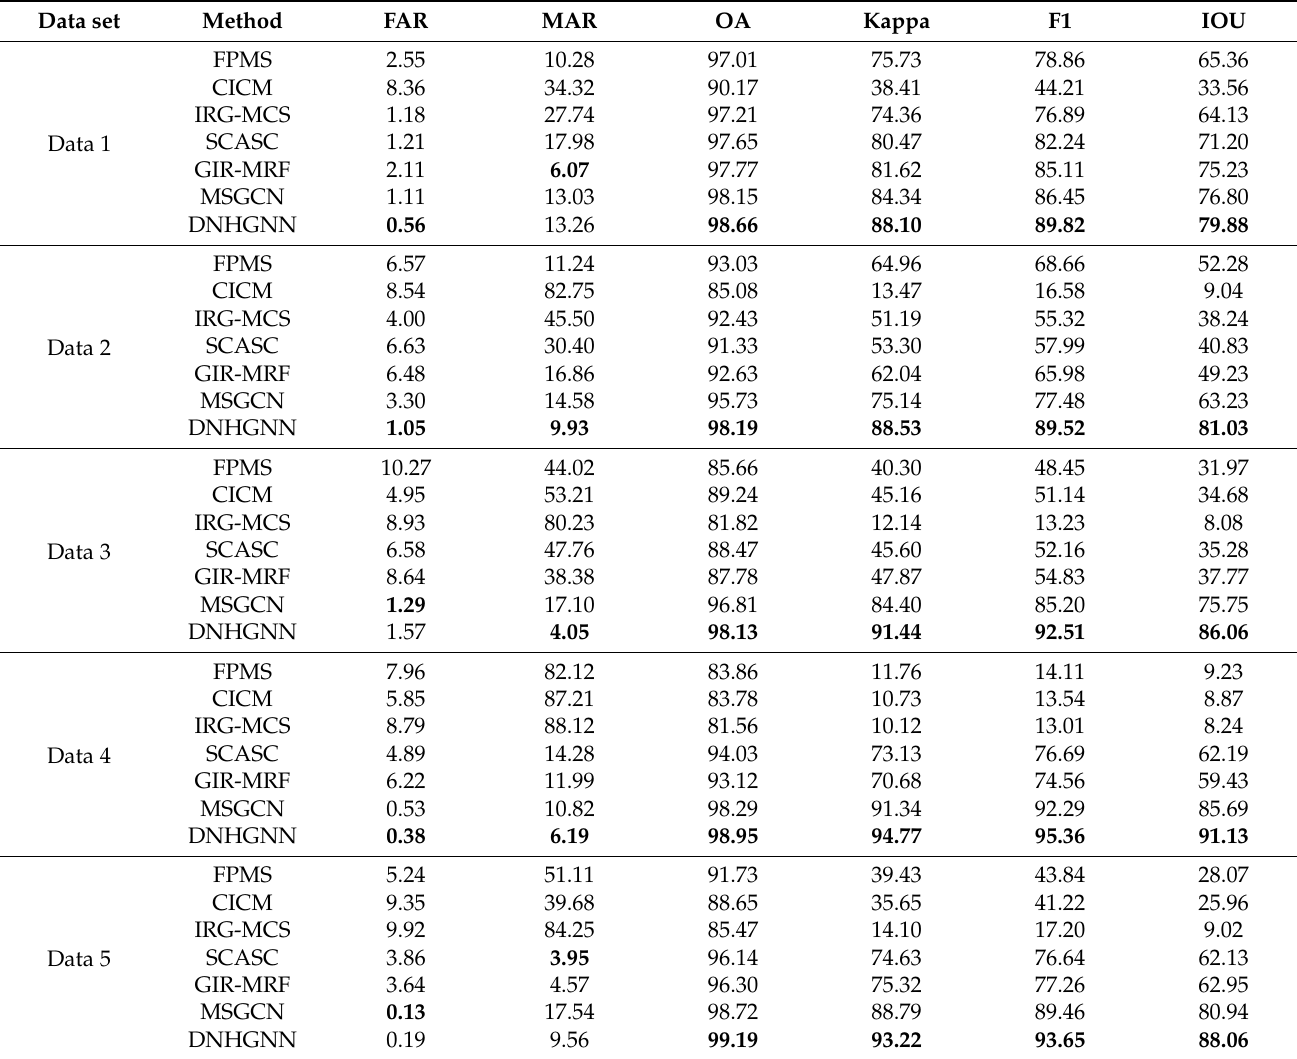
Table 3. Quantitative accuracy results for different methods on the heterogeneous data sets